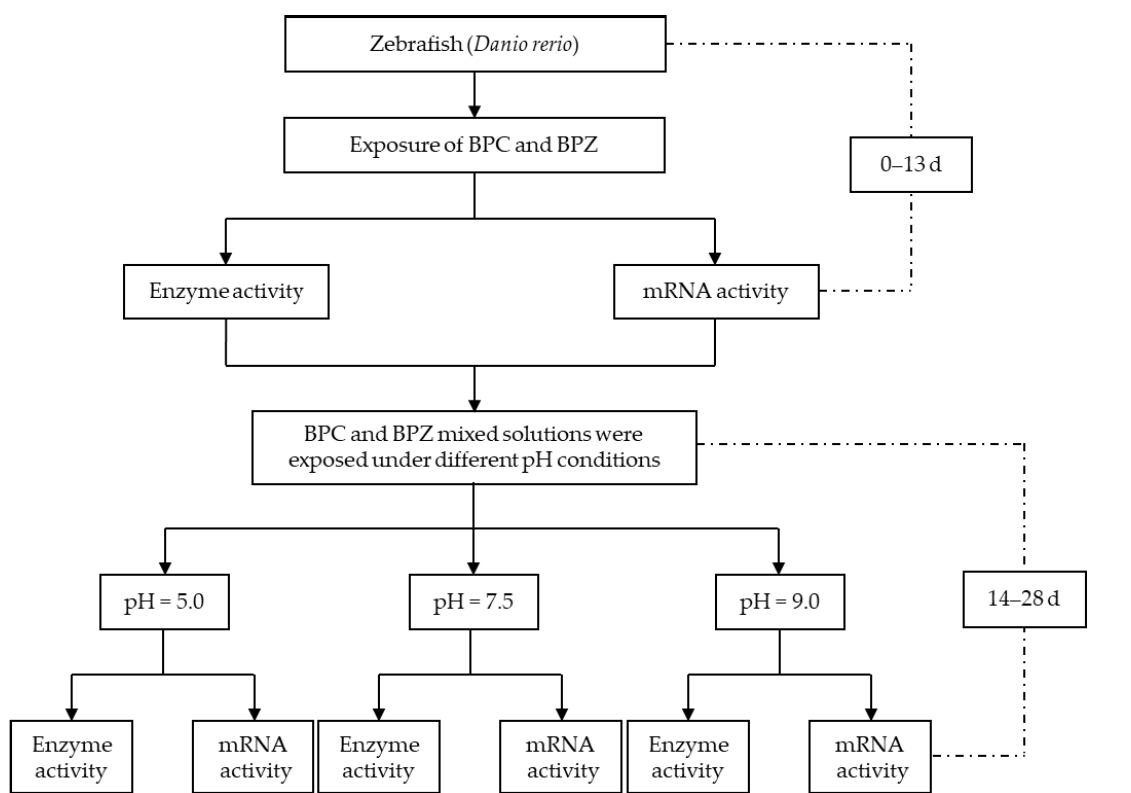
Figure 4. Flow chart of the experimental design in this study .